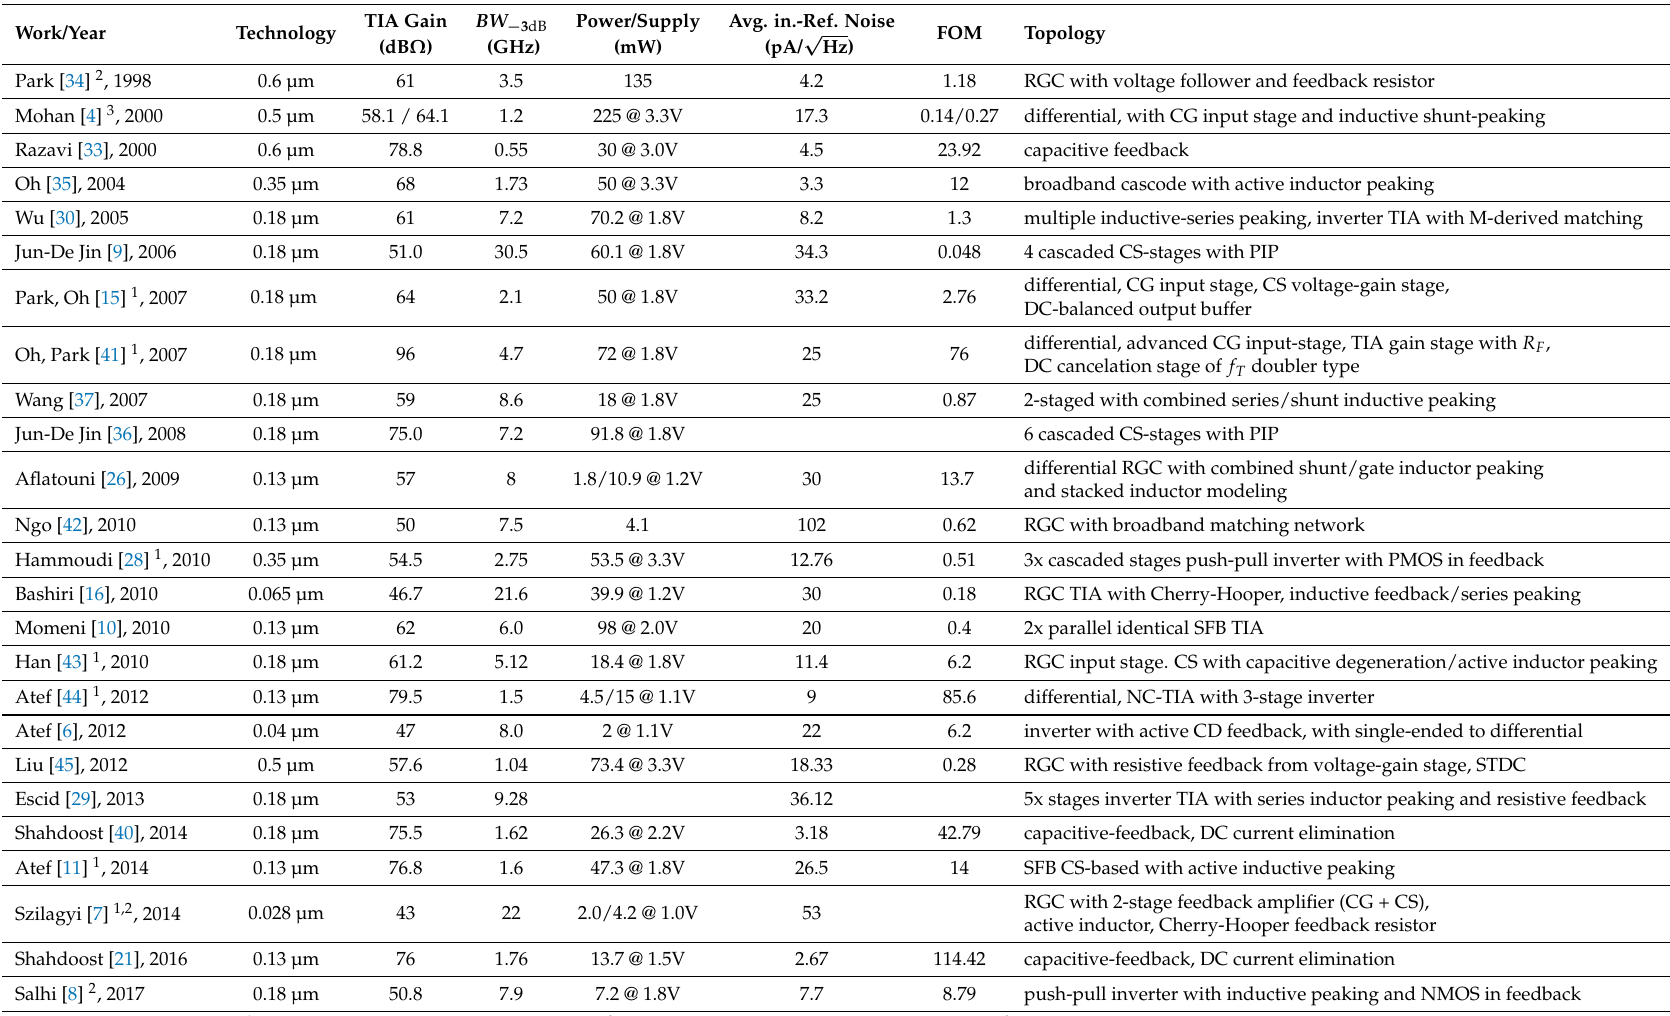
Table 2. Performance measures of several CMOS